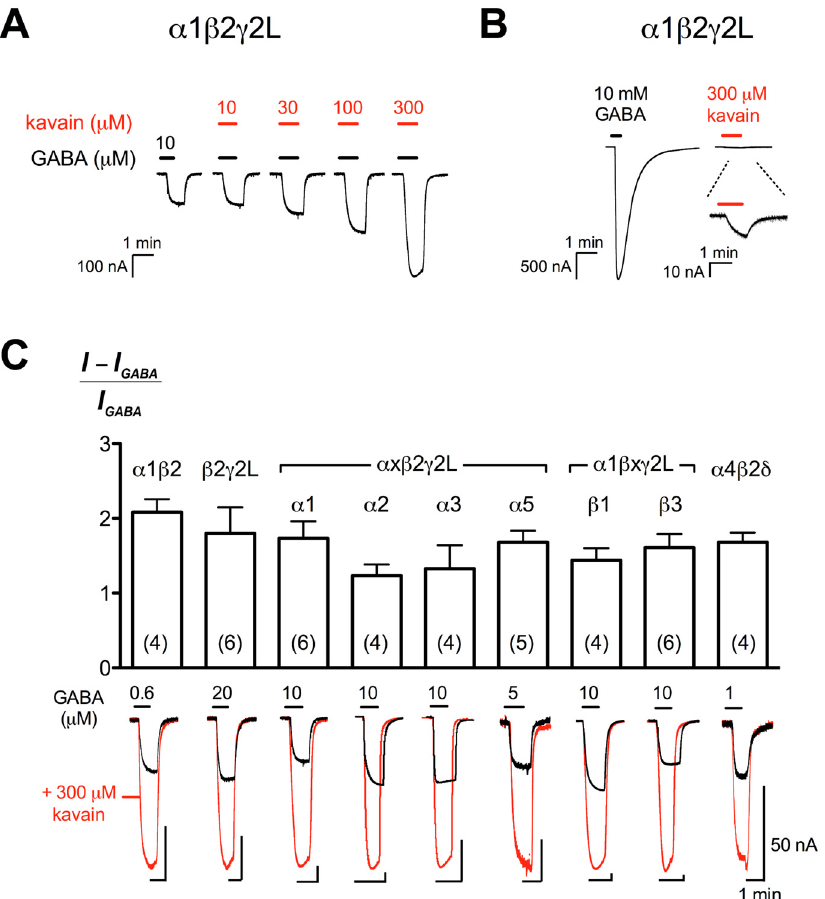
Fig 2. Kavain potentiates GABA A Rs with no apparent subtype selectivity. (A) Representative traces demonstrating kavain (10 – 300 μ M) enhancing current elicited by 10 μ M GABA (EC 3 ) at α 1 β 2 γ 2L GABA A Rs in a concentration-dependent manner. (B) Representative traces of current responses elicited by a maximal concentration of GABA (10 mM), in comparison to 300 μ M kavain alone. (C) Top panel , Potentiation of GABA-elicited currents (EC 3-7 ) at α 1 β 2, β 2 γ 2L, α x β 2 γ 2L (x = 1, 2, 3 and 5) and α 1 β x γ 2L (x = 1, 2 and 3) GABA A Rs by 300 μ M kavain. At α 4 β 2 δ GABA A Rs, the GABA control (1 μ M) corresponds to an EC 30 . Data are presented as mean ± SEM. Numbers in bars indicate the number of experiments. No significant difference was found for kavain potentiation at these receptor subtypes (Tukey ’ s test; p > 0.05 for all pairwise comparisons). Bottom panel , Superimposed current traces of GABA alone (black) and GABA in combination with 300 μ M kavain (red) at the corresponding receptor subtypes. The black bars above the traces indicate duration of drug